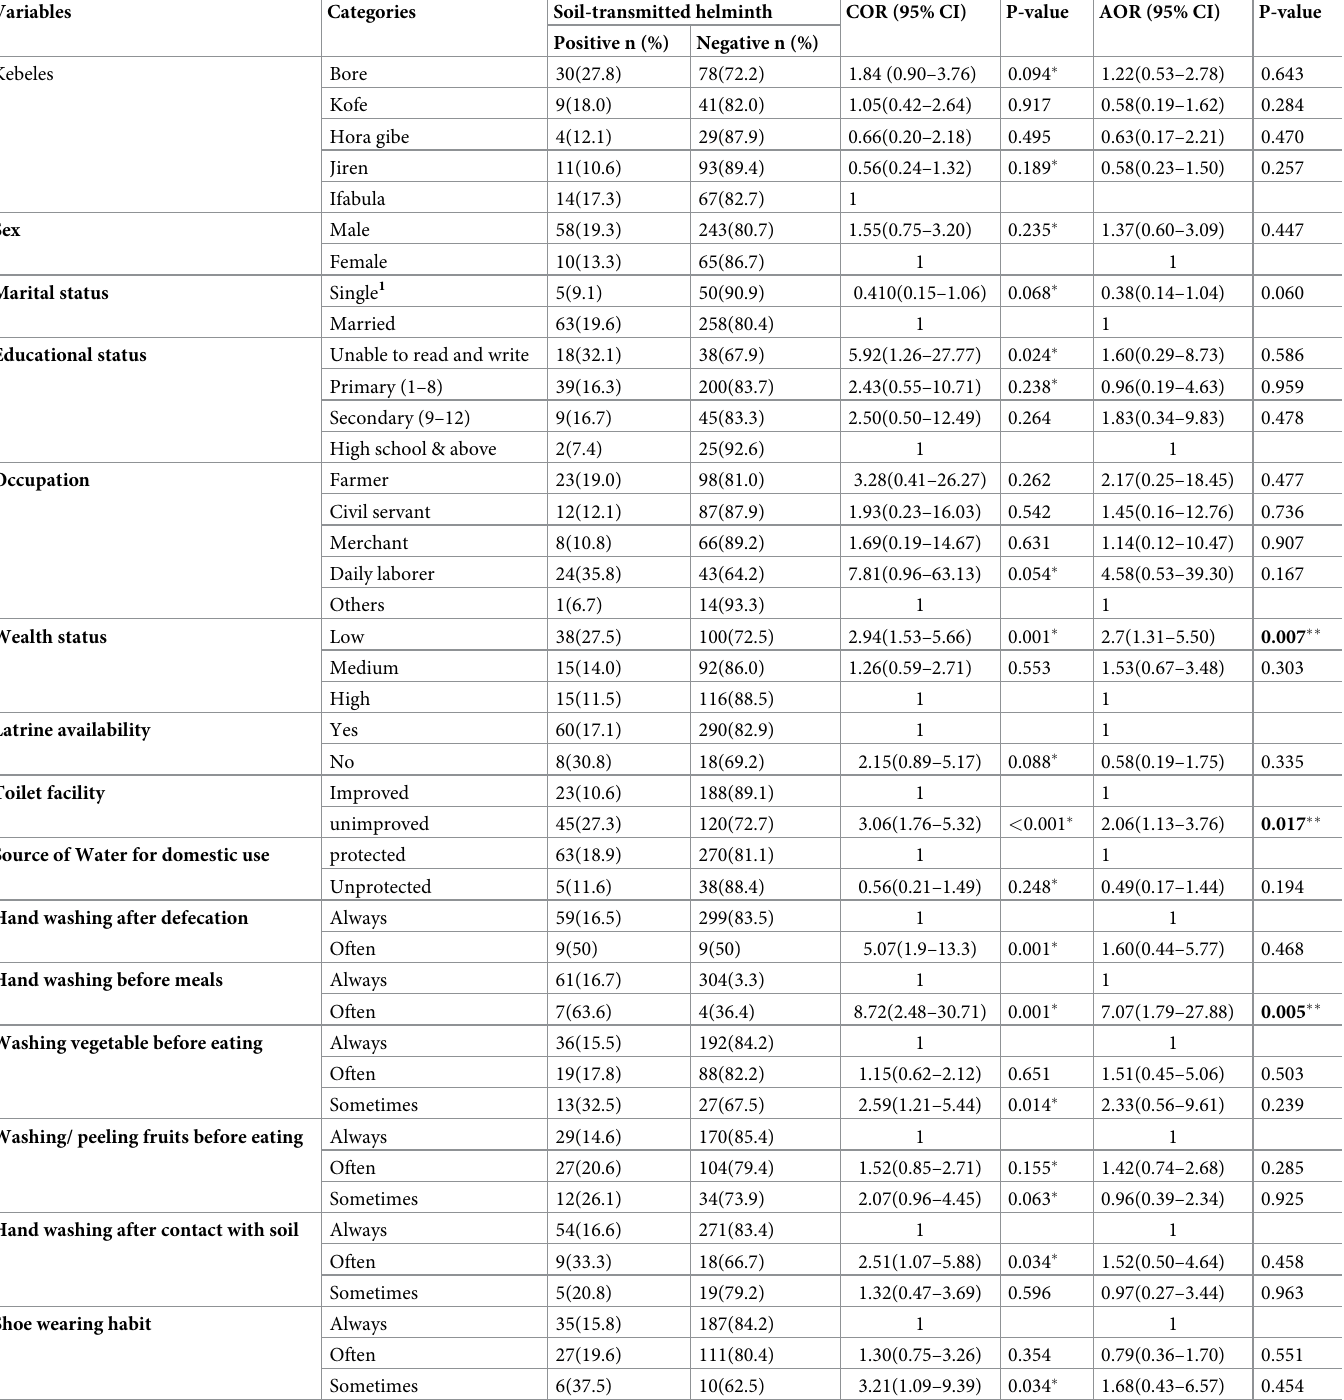
Table 4. Binary and multivariable logistic regression model to identify factors associated with STH infection among the household heads in the peri-urban area of Jimma town, Oromia, Ethiopia, May to July 2021(n =